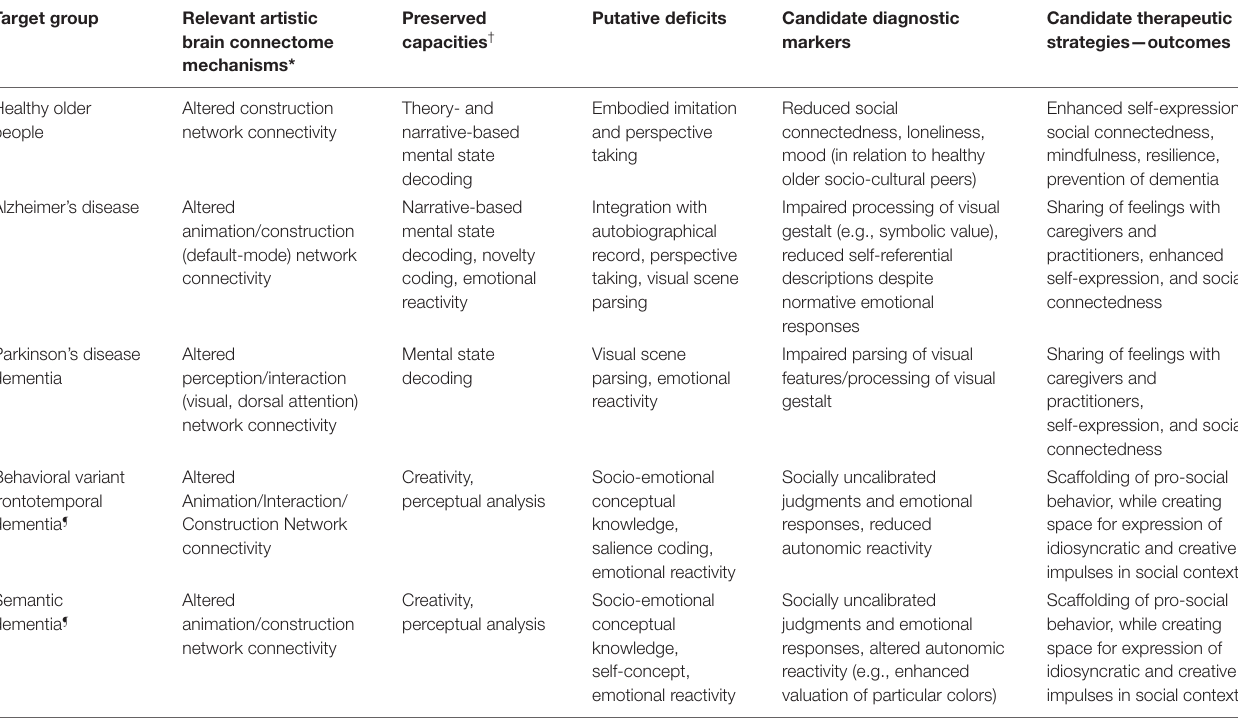
TABLE 2 | Some diagnostic and therapeutic considerations in clinical application of artworks for healthy aging and